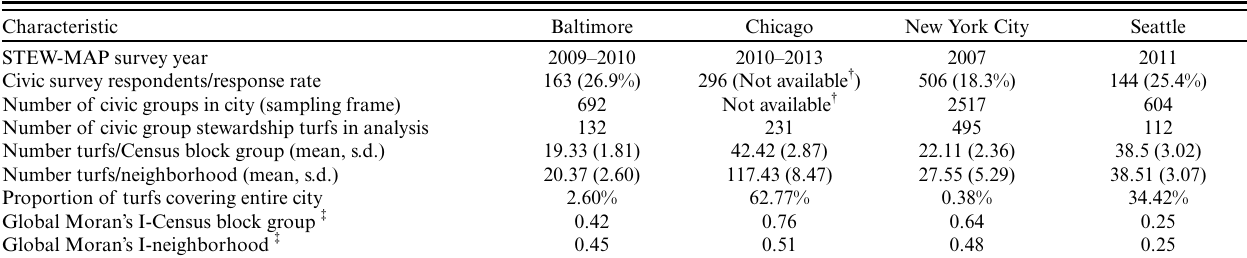
Table 2 . Stewardship Mapping and Assessment Project (STEW-MAP) survey and activity area attributes by study area city.